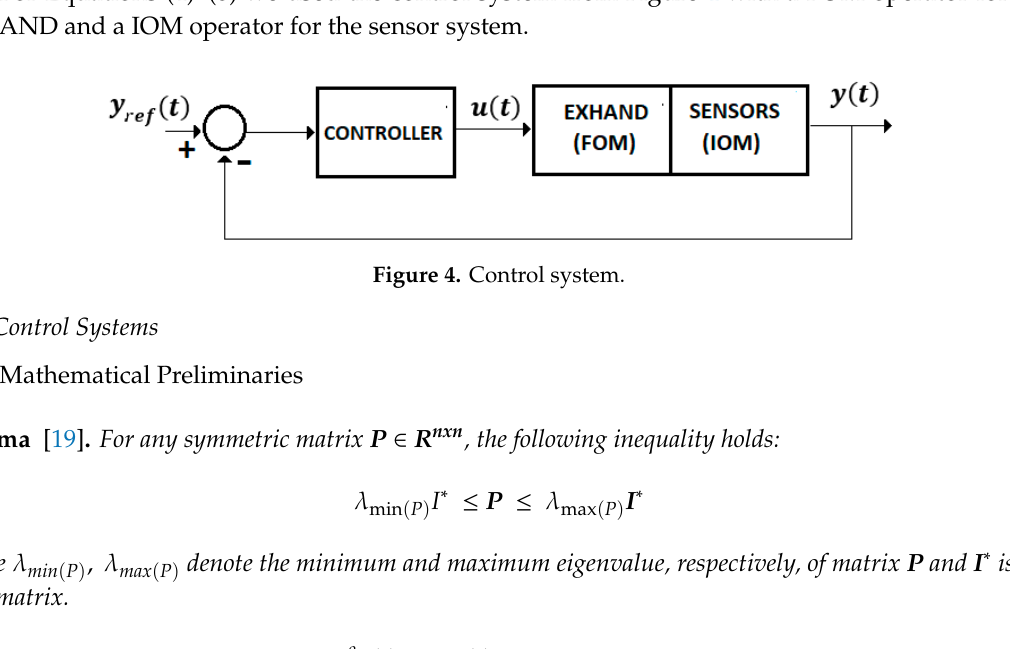
Figure 3. IHRG system.